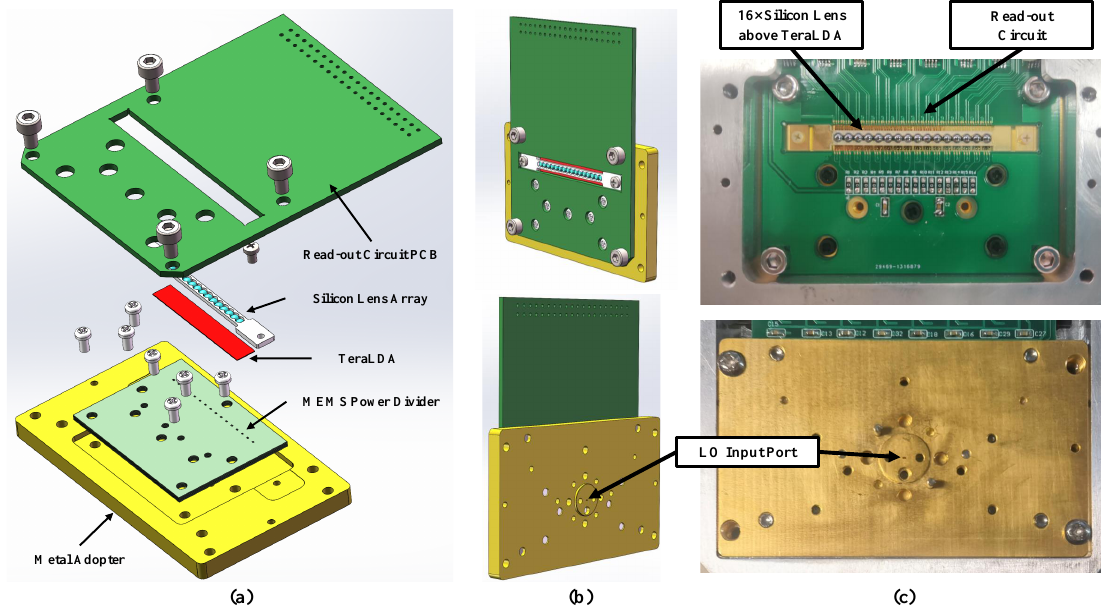
Figure 15. ( a ) Exploded view of the THz heterodyne receiver front-end. ( b ) The overall view of the THz heterodyne receiver front-end. ( c ) Photograph of the THz heterodyne receiver